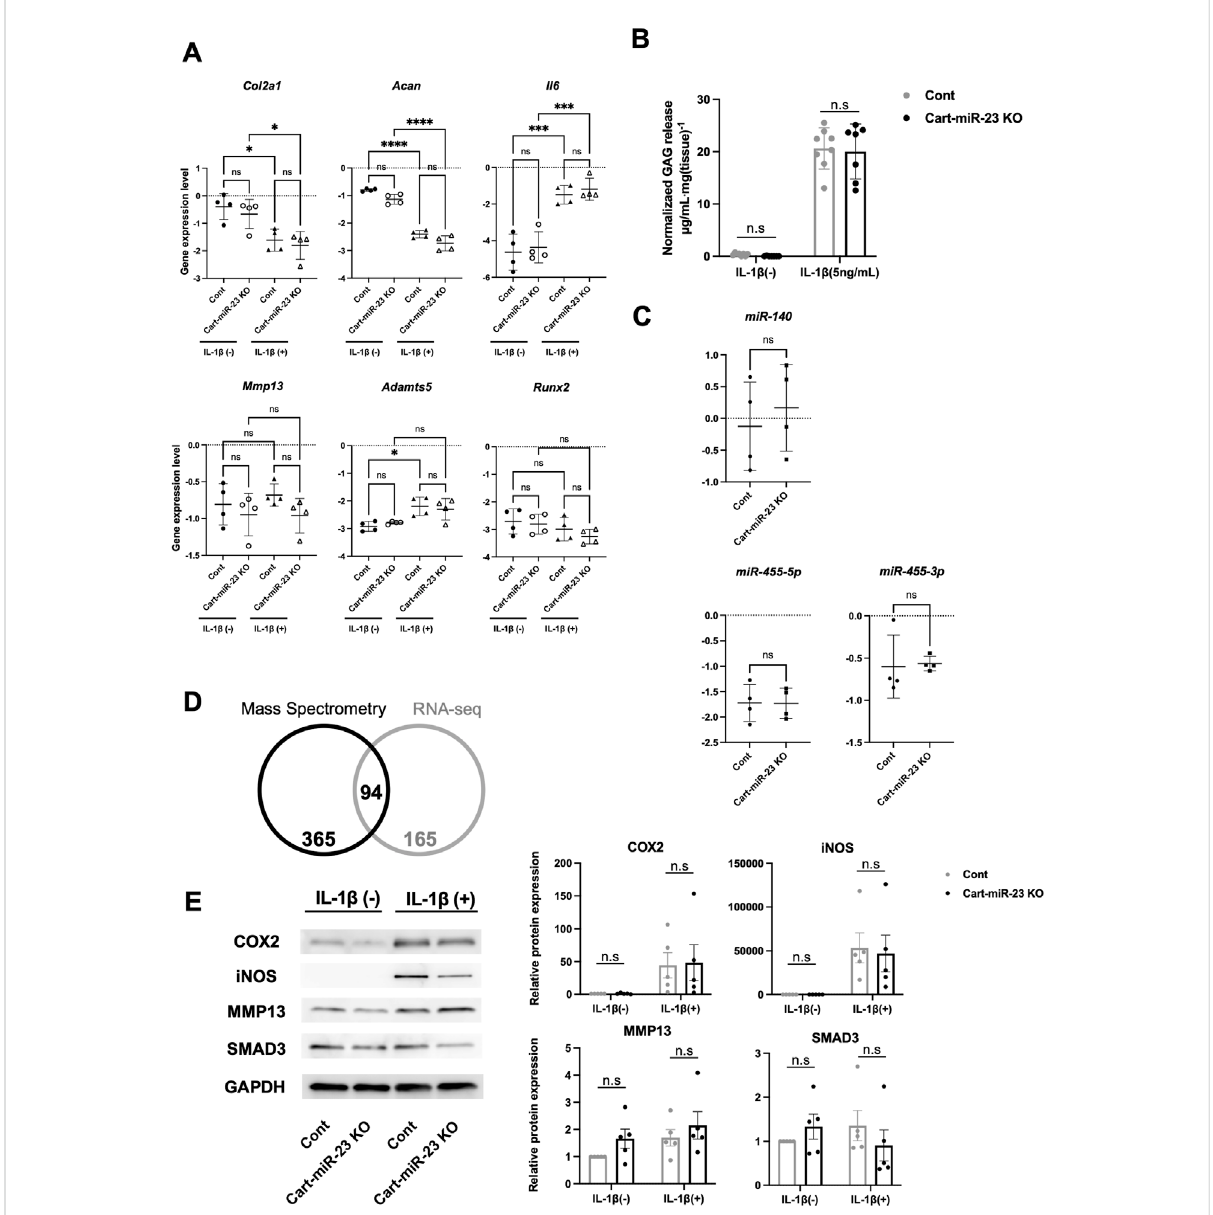
FIGURE 5 Osteoarthritis related markers in the articular chondrocytes of Cart-miR-23a/b KO mice. (A) Real-time PCR was performed to assess the OA- related genes expression in articular chondrocytes with or without IL-1 β treatment (1 ng/ml for 24 h) from Control and Cart-miR-23clus KO mice ( n = 4 each group) at 3 weeks of age. (B) Femoral head cartilage explants from Control and Cart-miR-23clus KO mice (Control: n = 8, Cart-miR- 23clus KO: n = 7) cultured with or without IL-1 β (5 ng/ml) for 72 h. Proteoglycan release into the conditioned medium from articular cartilage was assayed as the concentration of glycosaminoglycan (GAG). (C) Expression of cartilage-related miRNAs in Control and Cart-miR-23clus KO articular chondrocytes by real-time PCR ( n = 4 each group). (D) Venn diagram comparing upregulated proteins and mRNAs (Cart-miR-23clus KO/ wild-type mice)inproteomeanalysis andtranscriptomeanalysis. (E) WesternblottingofNF- κ B-dependent proteins inControlandCart-miR-23clus KO articular chondrocytes ( n = 5 each group) with or without IL-1 β treatment. All data represented as mean ± SEM. Comparison of gene expression (A) , GAG release (B) and protein expression (E) were performed using one-way ANOVA Sidak ’ s multiple comparisons test. Comparison of mean values (C) was performed using Welch ’ s t -test. * p < .05, ** p < .01, *** p < .001, **** p < .0001. n. s: non-signi fi cant